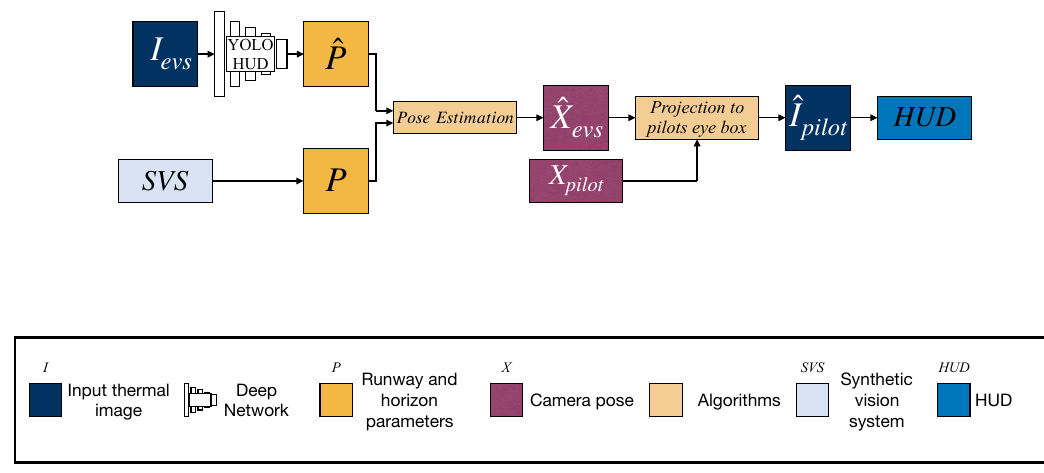
Figure 2. The proposed pipeline for re-projecting of the EVS